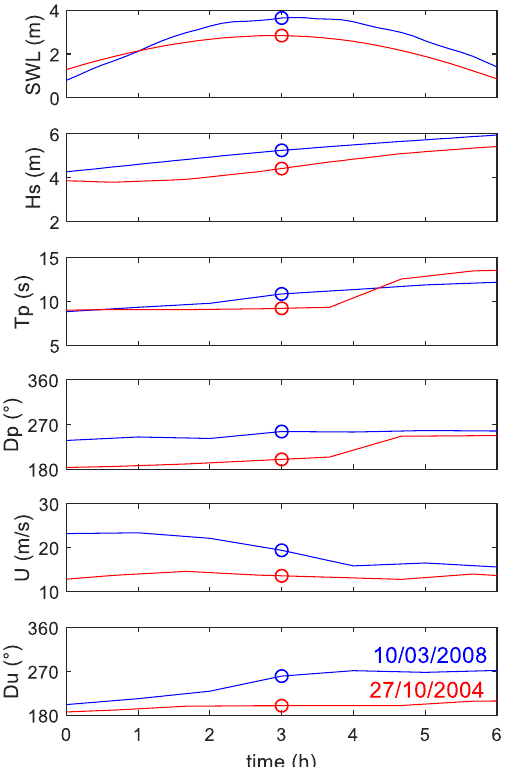
Figure 4. Forcing conditions of the modeling chain, for the 27 / 10 / 2004 (in red) and 10 / 03 / 2008 (in blue) events, from high-tide minus 3 h to high tide plus 3 h. The still water level (SWL) is given with respect to the national vertical datum IGN69.